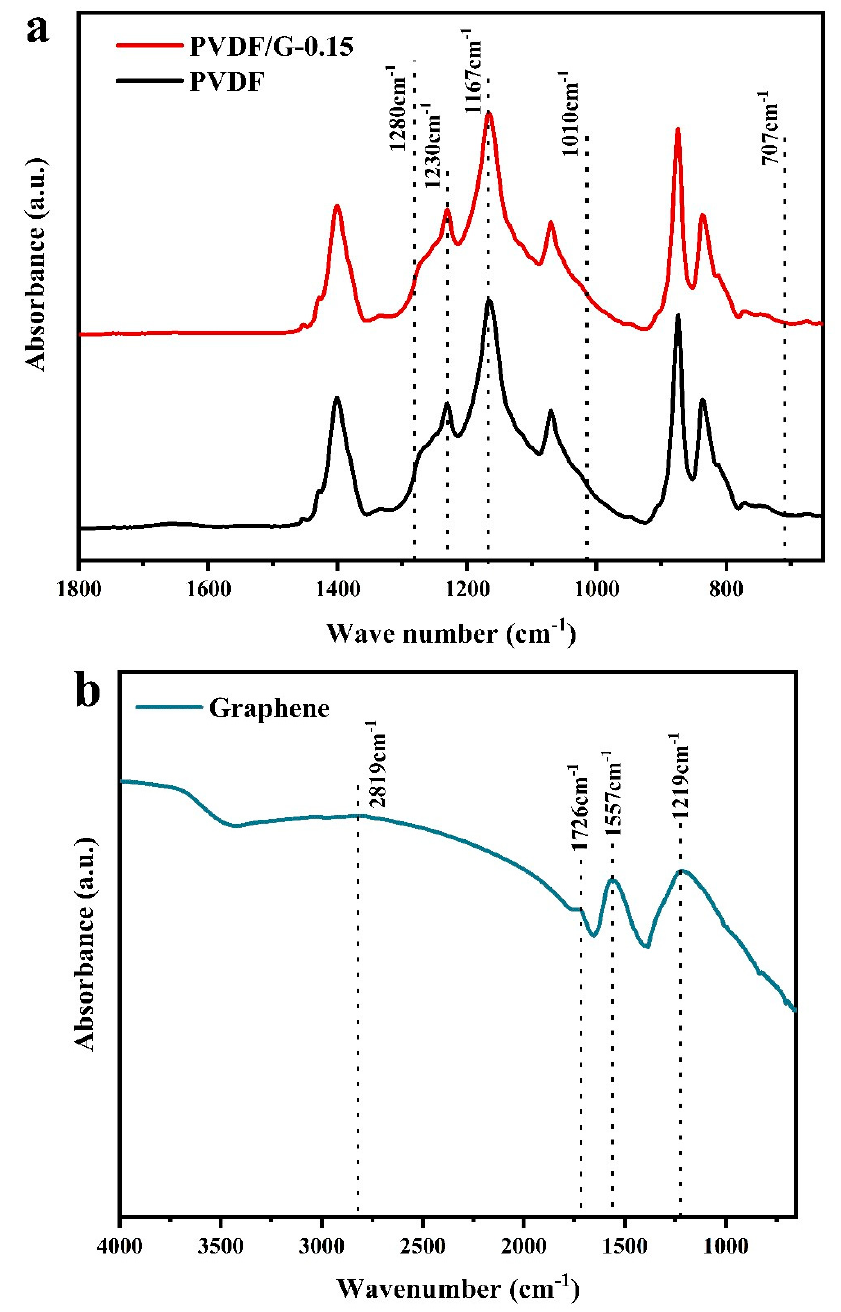
Figure 4. ( a ) ATR spectra of PVDF and PVDF/G-0.15 membranes; ( b ) FT-IR spectrum of the graphene.